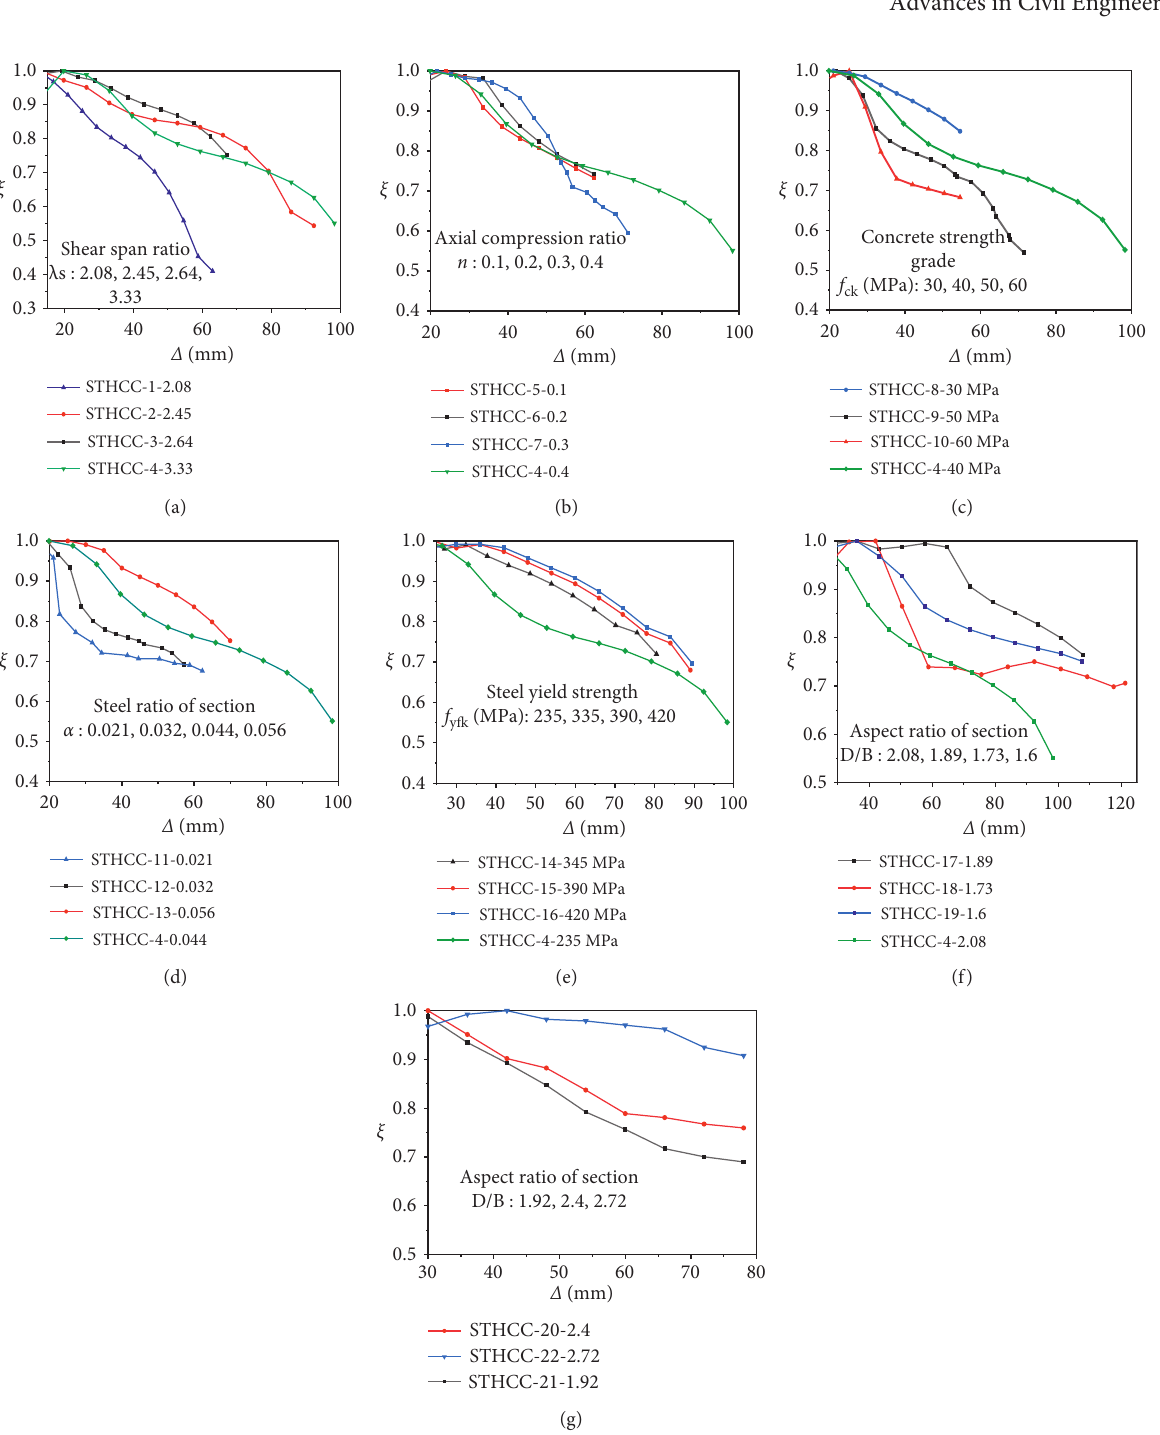
s : 2.08, 2.45, 2.64, 3.33. (b) n : 0.1, 0.2, 0.3, 0.4. (c)